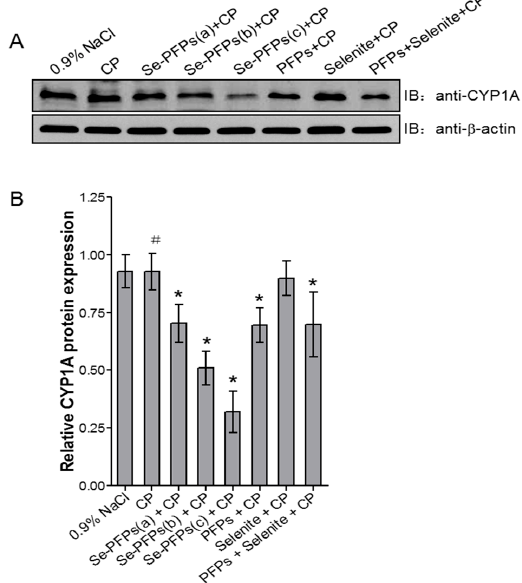
Figure 2. Effects of administration of Se-PFPs, PFPs, selenite, and PFPs + selenite on relative protein levels of CYP1A in mouse liver microsome by Western blotting: ( A ) representative bands showing the changes in CYP1A protein levels after different treatments; and ( B ) the protein levels of CYP1A in relative to that of β -actin of corresponding treatments. All the values are shown as means ± SD ( n = 10). # p > 0.05, compared with 0.9% NaCl; * p < 0.05, compared with CP. PFPs, polysaccharide from P. fortuneana , Se-PFPs, polysaccharide from Se-enriched P. fortuneana , and PFPs + selenite, the combination of PFPs and